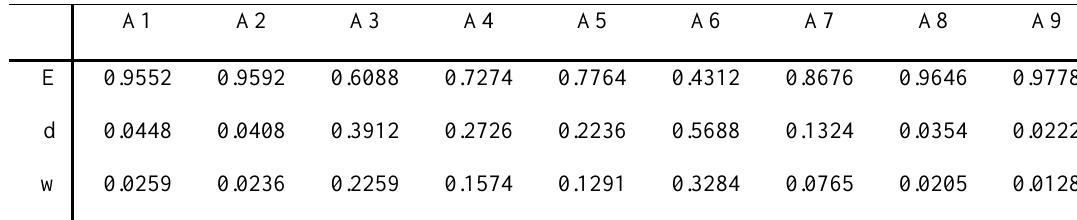
Table 2. Determine the weights of the